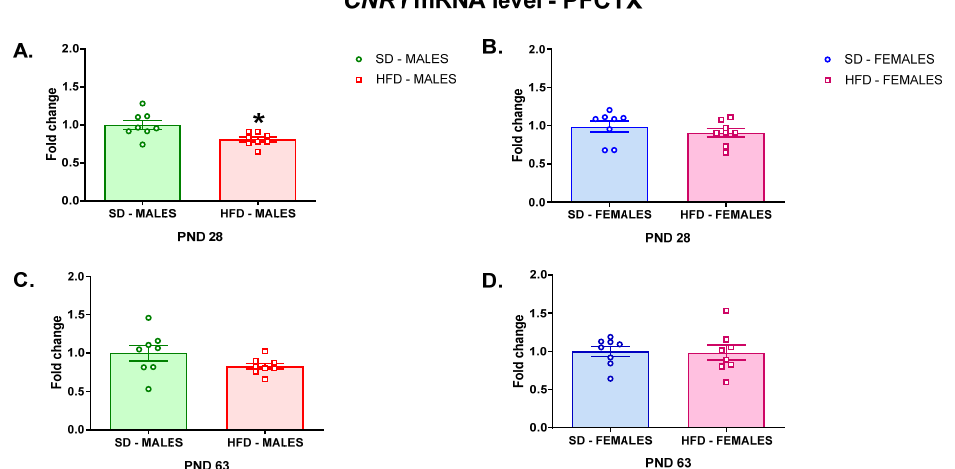
Figure 1. Changes in the Cnr1 mRNA level in the PFCTX of adolescent ( A ) male and ( B ) female offspring or young adult ( C ) male and ( D ) female offspring whose mothers were fed on an SD or HFD during pregnancy and lactation. HFD—high-fat diet; PFCTX—prefrontal cortex; PND—postnatal day; SD—standard diet. Data are presented as the mean ± SEM with individual value plots. N = 8 rats/group. * p < 0.05 vs. SD.